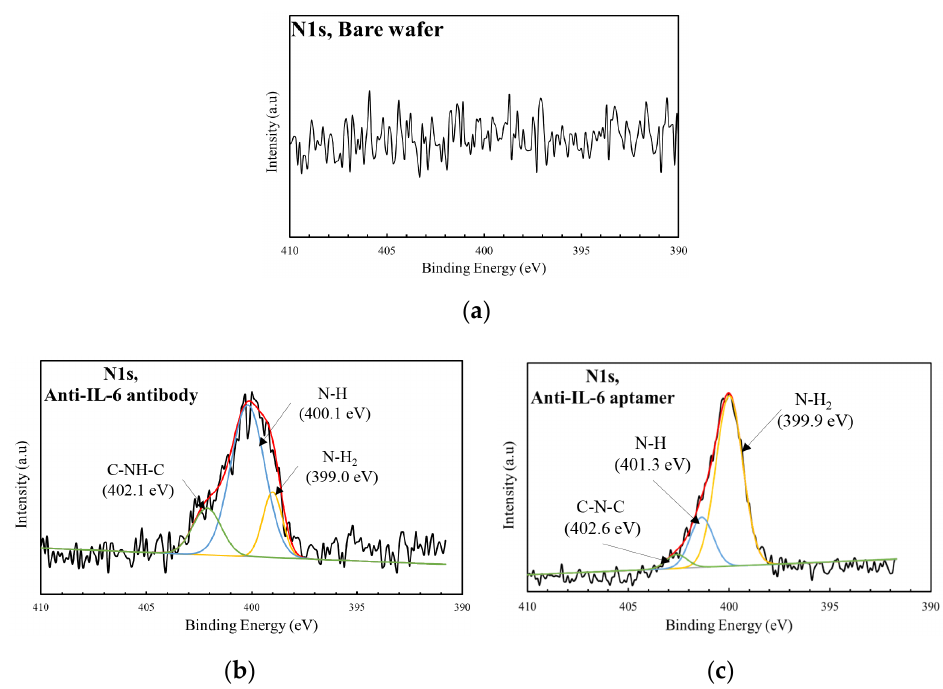
Figure 4. High-resolution spectra of N 1 s ( a ) bare silicon wafer, ( b ) Si-mSAMs-GA-Ab surface, and ( c ) Si-mSAMs-GA-Apt surface.